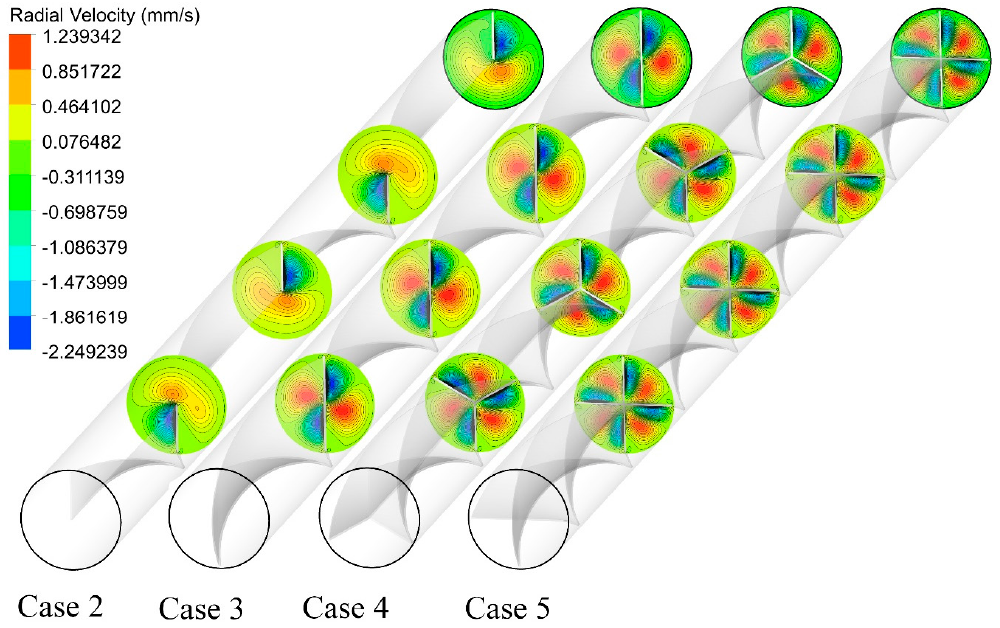
Figure 9. Cross-sectional radial velocity contours for the captured cases at Re = 250 and φ = 0%. Figure 10 shows the cross-sectional tangential velocity contours for different cases at an Re of 250. The multiple semi-twisted tapes with N = 4 generate a higher tangential velocity and enhances the heat and mass transfer between the central fluid and near-wall regions. This improves the synergy degree between the velocity fields and temperature gradient Figure 10. Cross-sectional tangential velocity contours for the captured cases at Re = 250 and φ = 0%.